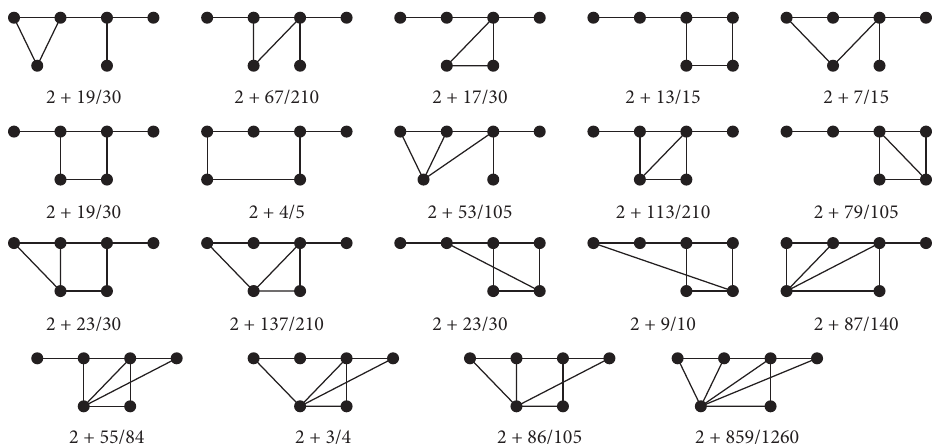
Figure 5: Quasi-tree graphs of order 6 obtained from K ∗